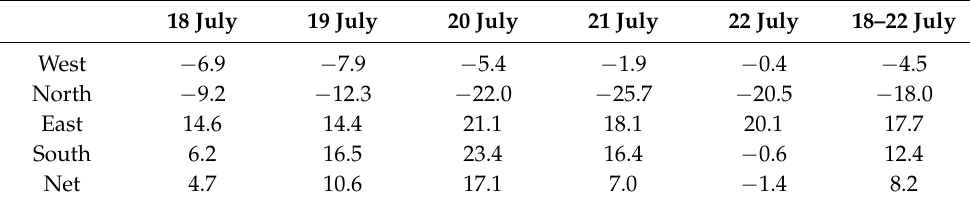
Table 2. Net water vapor flux (unit: 10 × 10 7 kg/s) at four boundaries of Henan during 18 – 22 July 2021. Positive and negative values represent water vapor input and output, respectively.